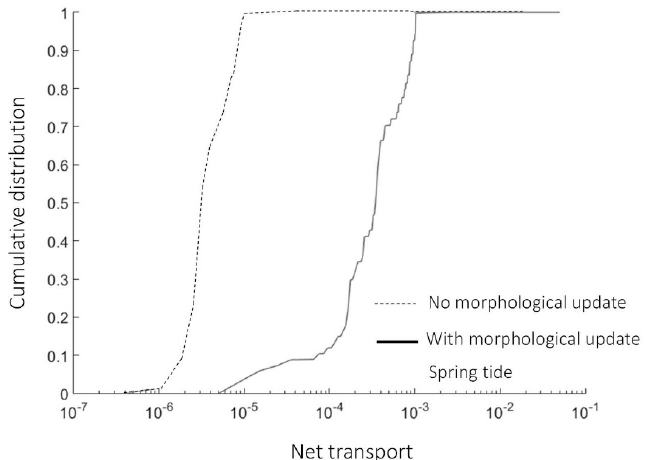
Figure 4. Net transport (m 3 /s/m) before ( A ) and after ( B ) the morphological evolution of the system (m 3 /s/m).